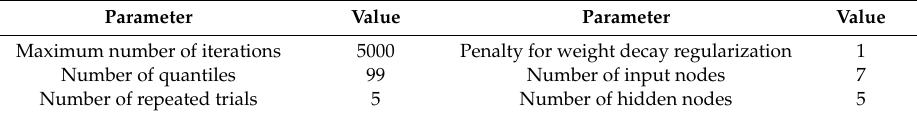
Table 1. The parameters utilized in the QRNNs modeling for the Fanjiaping landslide.